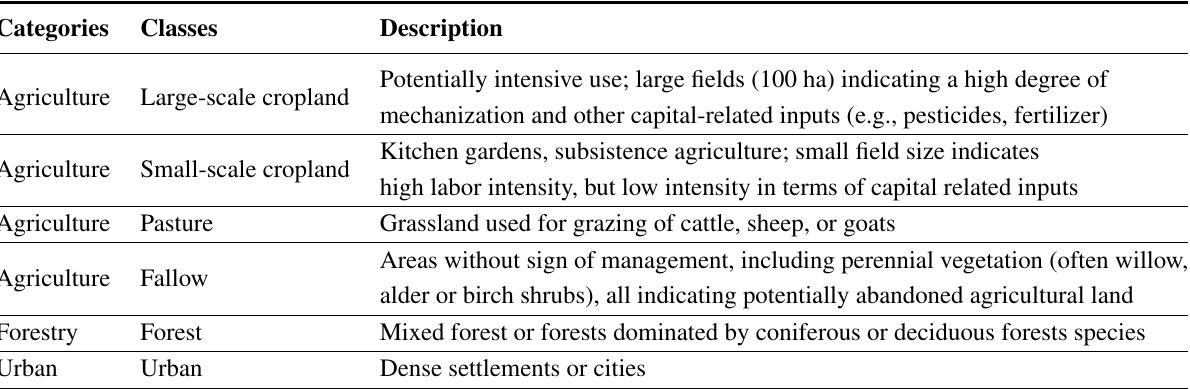
Table 1. Land categories, defined classes, class